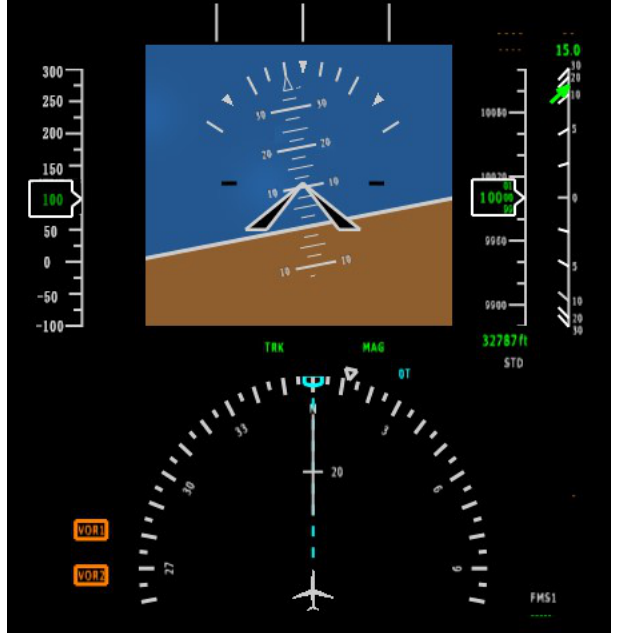
Figure 10. Dynamic display of the display server when flying height is 10,000